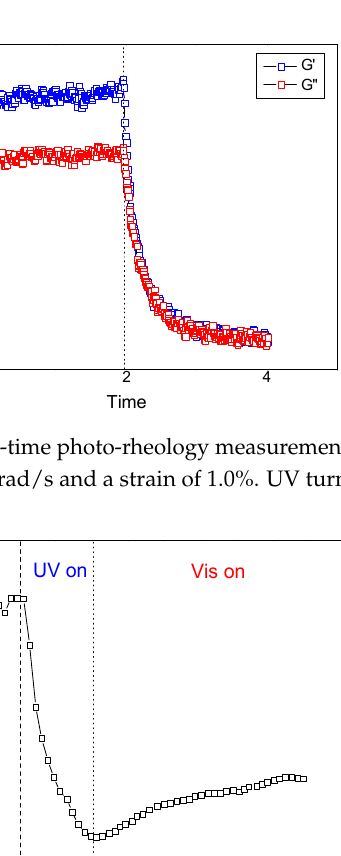
Figure 11. Plot of viscosity against the temperature of C4-Azo-C5-HDA in water (2.0 wt%). The data were obtained at a constant frequency of 5 rad/s and a strain of 1.0%.